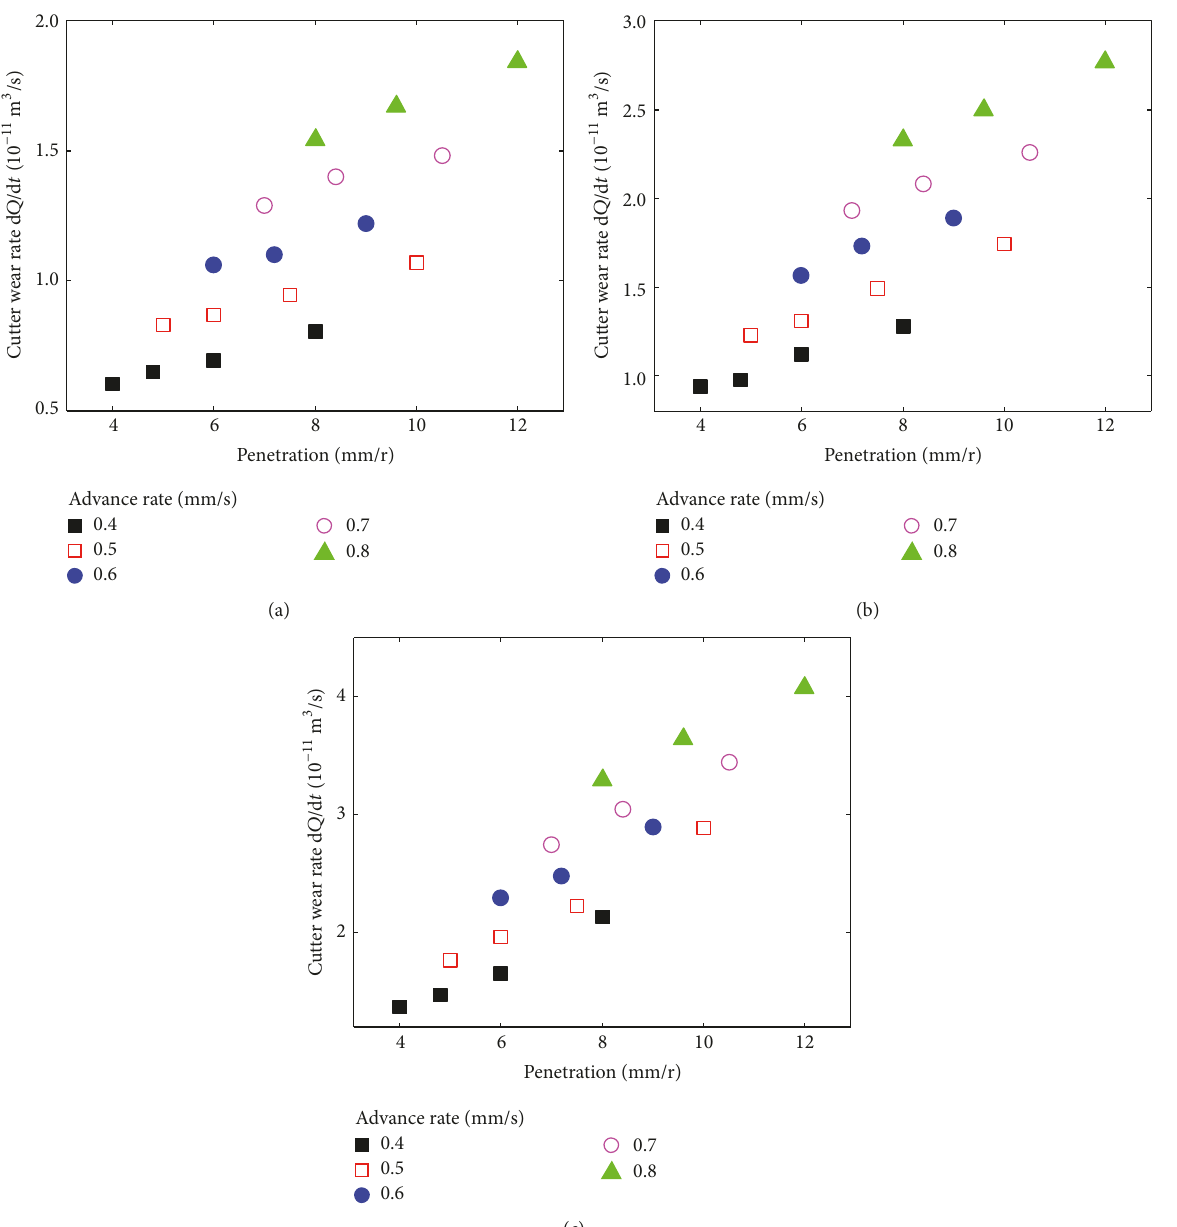
Figure 8: Correlation of cutter wear rate and operational parameters for (a) soft rock, (b) moderately hard rock, and (c) hard